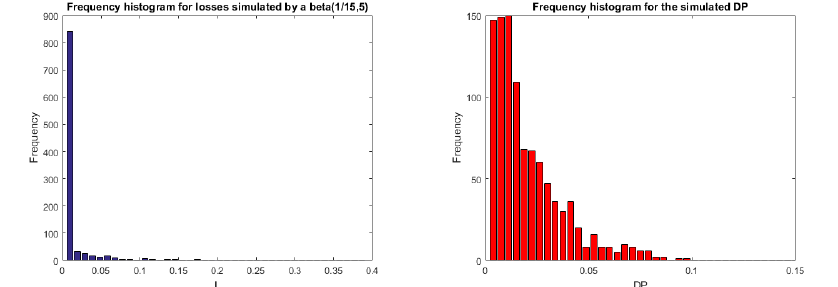
Figure 3: Histogram representing the frequency of occurrences of 1000 values of L and DP. We remark the fact that banks have different portfolios from each other, and that the portfolios are time changing, therefore taking into consideration simulated portfolios is not less accurate than considering samplings that are relatively small w.r.t.the wide empiric